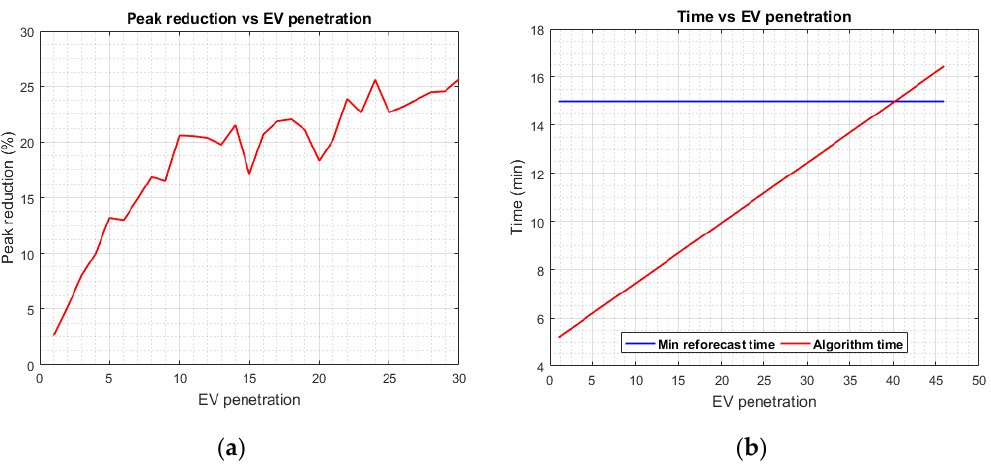
Figure 5. EV penetration analysis ( a ) Peak reduction ( b ) Algorithm time.